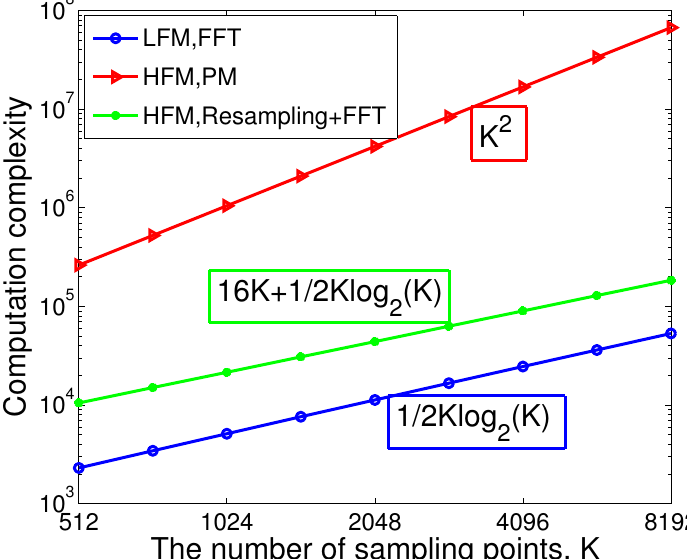
Figure 3. The computational complexity of the proposed pulse compression method for the HFM and LFM